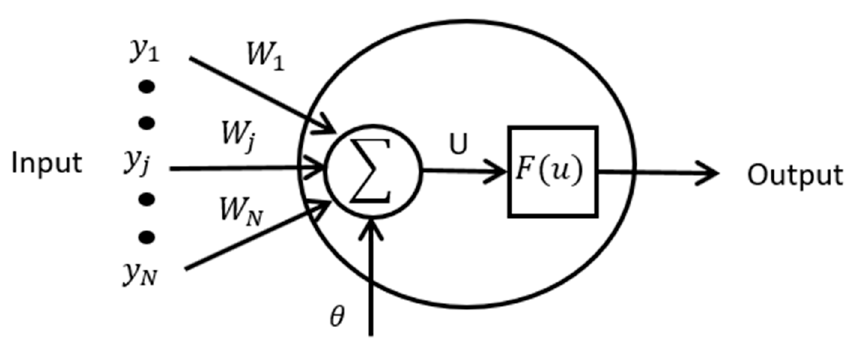
Figure 7. Neural Network model structure.